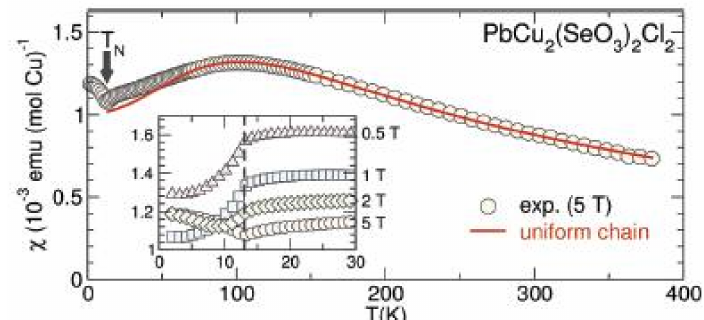
Figure 9. Magnetic susceptibility of PbCu 2 (SeO 3 ) 2 Cl 2 (circles) and the fit (solid line) using a uniform Heisenberg chain model with J 1 = 160 K, g = 1.97, and the temperature independent contribution × 10 − 5 emu (mol Cu) − 1 . The kink at 13 K indicates long-range magnetic ordering. Inset: χ 0 = 2 field dependence of χ (T). The strong dependence of χ on the magnetic field above T N is an extrinsic effect (ferromagnetic impurity). Reproduced from Ref. [29] with permission from the Royal Society of Chemistry.